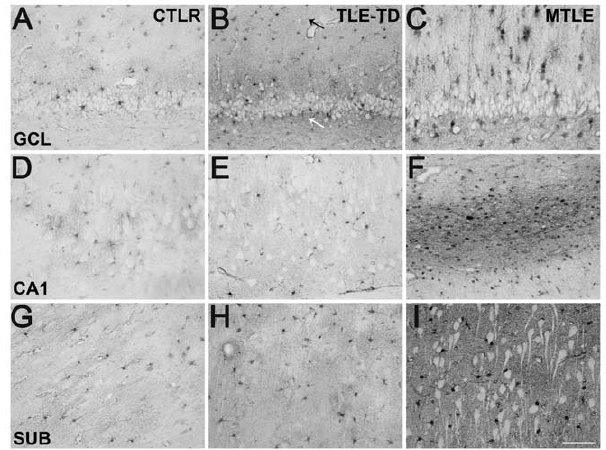
Figure 9. Representative sections of MT-I/II immunohistochem- istry in hippocampal subfields from Ctrl, TLE-TD and MTLE patients. MTLE patients had widespread increase in MT-I/II when compared to Ctrl, demonstrated by increased cellular and neuropil staining in C, F and I. In TLE-TD patients, increased MT-I/II expression was observed only in the fascia dentata (B) outer molecular layer (small black arrow) and subgranule zone (small white arrow), the entry point of the hippocampus. The representative images shown are from the fascia dentata (A–C), CA1 (D–F) and subiculum (G–I). Bar in I indicates 100 micrometers.